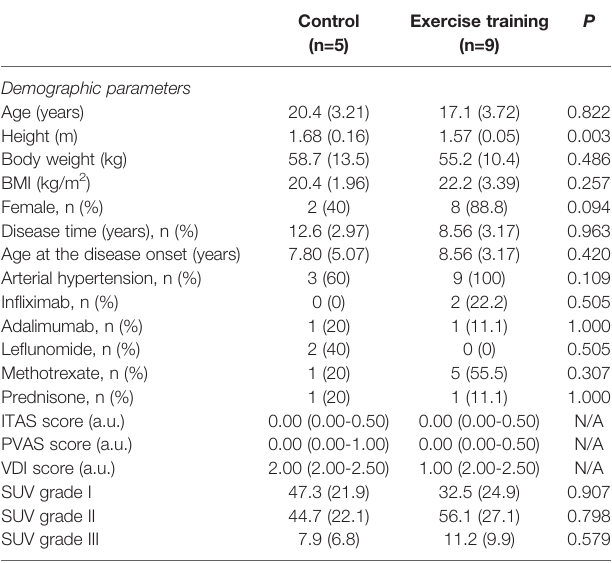
TABLE 1 | Baseline, demographic, and disease-related parameters in childhood-onset Takayasu arteritis